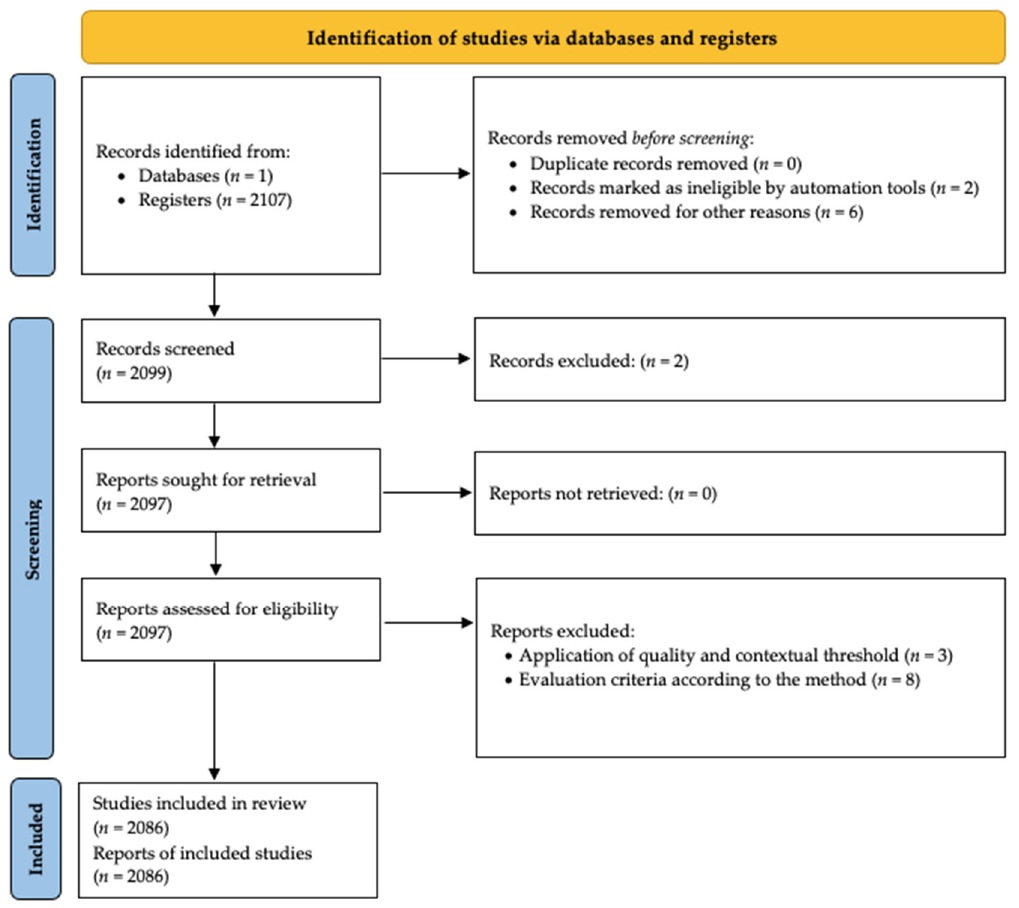
Figure 1. Systematic literature review strategy for bibliometric analysis.